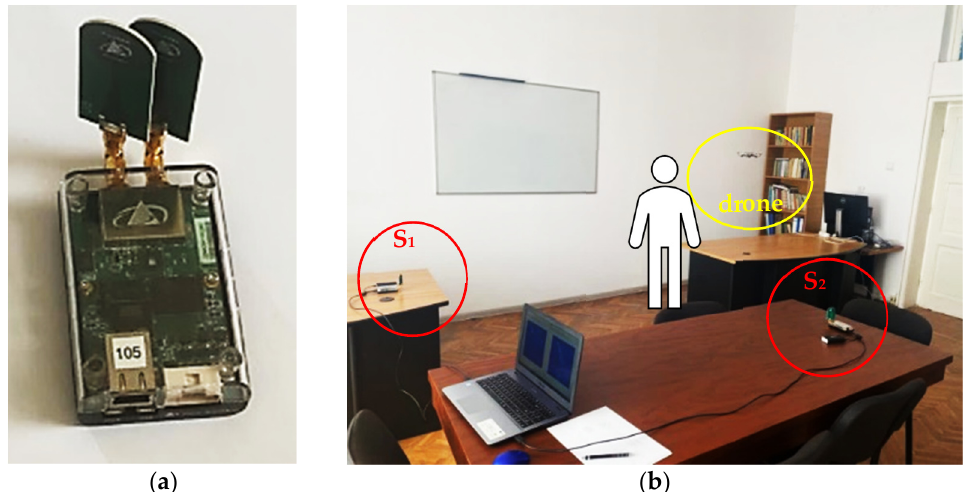
Figure 3. The PulsON 440 UWB sensor ( a ) used for the LSS UAV–human movement characterization and their placement ( b ) for the experimental setup.